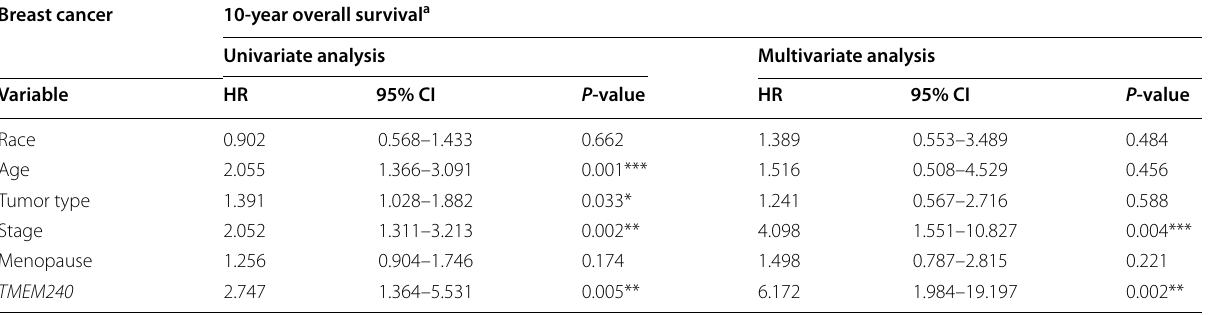
a These results were analyzed by the Cox regression model b The TMEM240 DNA methylation levels were derived from 640 breast cancer patients in TCGA data set